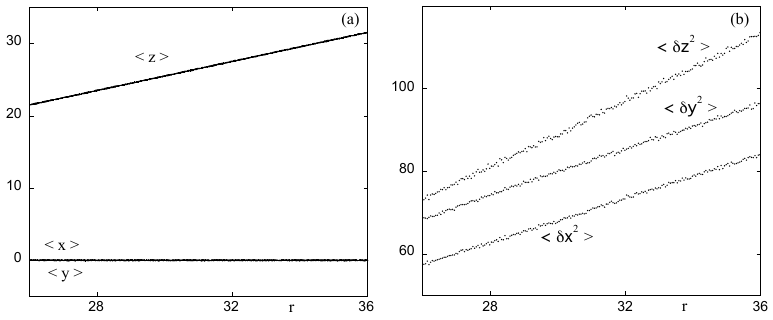
Figure 8. Ensemble averages (a) and variances (b) of variables x , y , and z of model (13) in the chaotic regime versus the instantaneous value of the ramp parameter r starting from r 0 = 26 with (cid:15) = 0 . 01. The number of initial conditions is 100000.